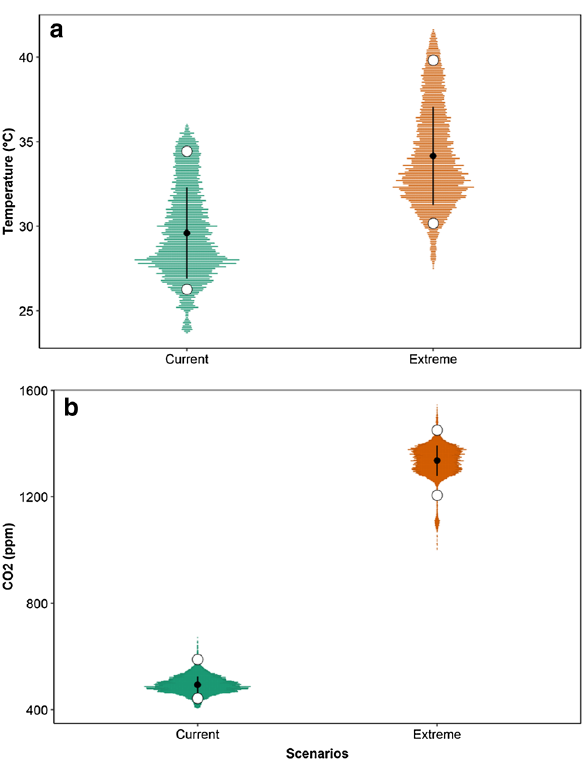
Figure 5. Variations in air temperature ( a ) and CO 2 concentration ( b ) in the two environmental rooms, as proposed by IPCC (2014) for the year 2100 over the 30-day experimental